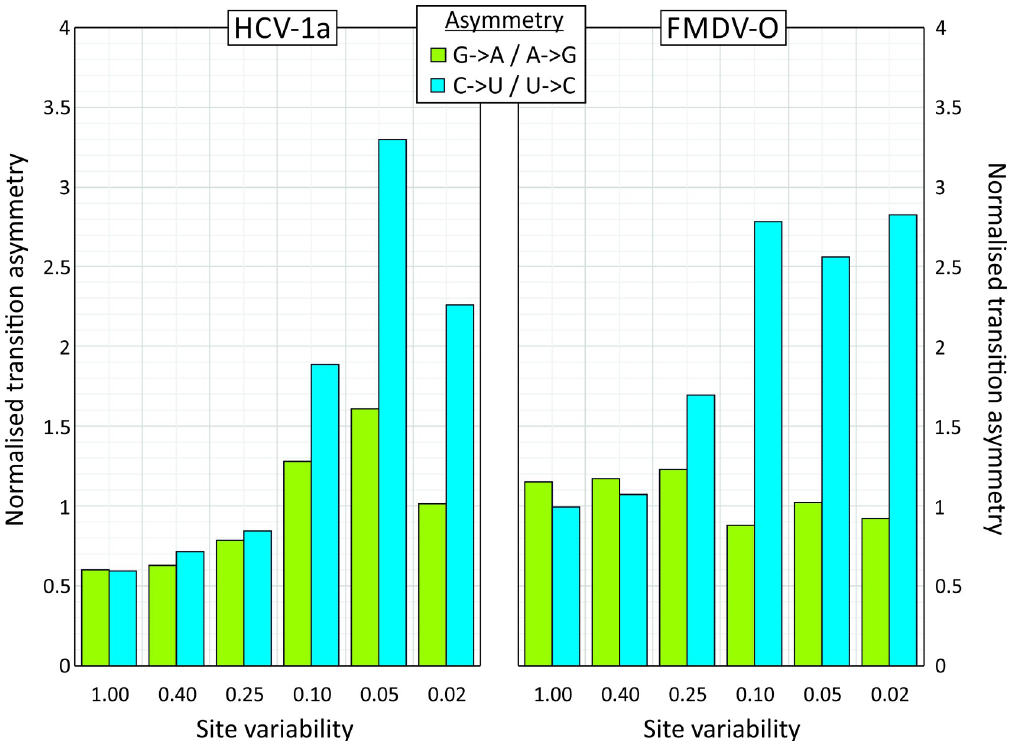
Fig 2. Frequency related transition asymmetries. Transitional asymmetries of two virus datasets showing C- > U/ G- > A asymmetries. Normalised values (y-axis) were calculated for sites showing different levels of sequence heterogeneity (x-axis): 0.02: 0.02 or less; 0.05: < 0.05 and � 0.02; 0.1: < 0.1 and � 0.05; 0.25: < 0.25 and � 0.1; 0.4: < 0.4 and � 0.25; 1.00: � 0.4.